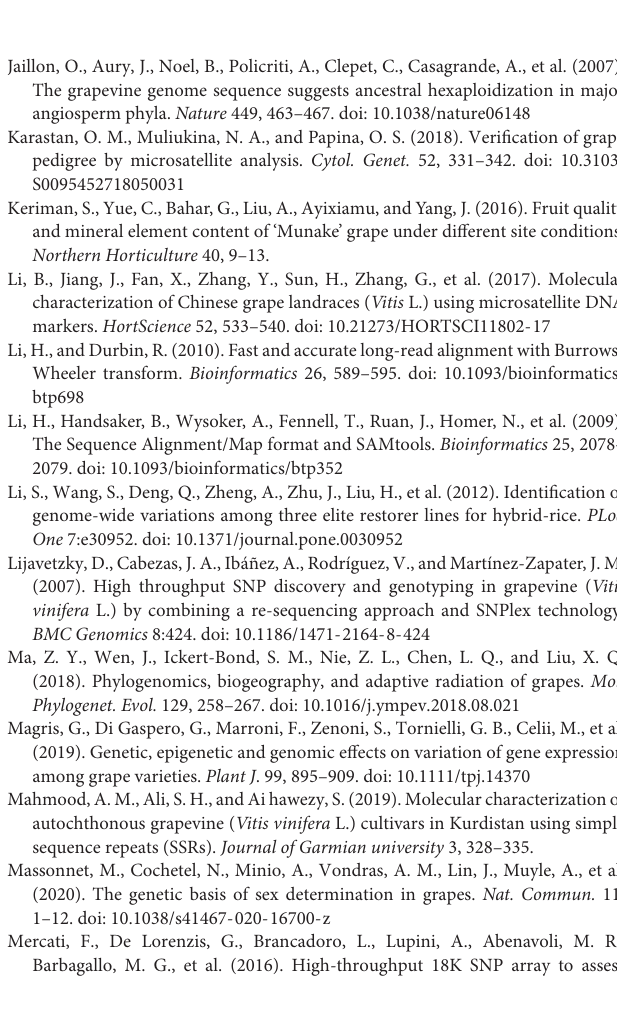
Supplementary Table 1 | The primers for detecting 44 microsatellite